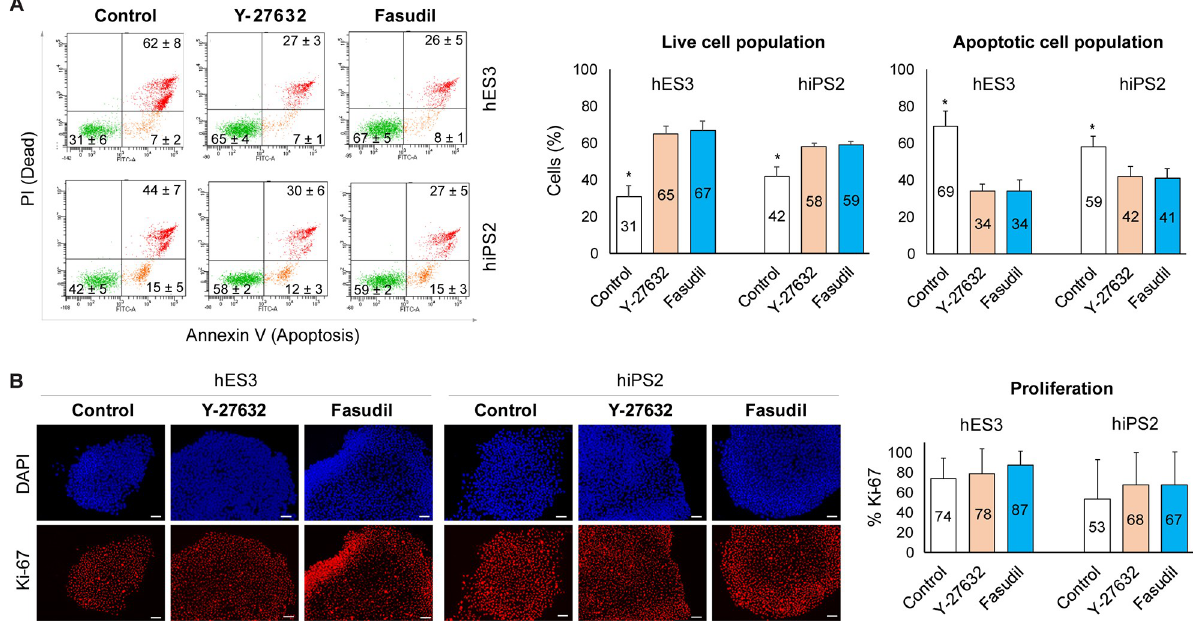
Fig 3. The mechanism of PSC growth. A: Analysis of live and apoptotic hES3 and hiPS2 cells (%) 24 hours after seeding at 1 × 10 4 cells/cm 2 . Compared with the control group, apoptotic cells decreased when treated with fasudil ( � : p < 0.05; 3 biological replicates). B: Cell proliferation measured using immunofluorescence (left) and flow cytometry (right) to examine Ki-67 expression in hES3 and hiPS2 cells 2 days after seeding. There were no significant differences between the groups (3 biological replicates). Scale bar = 100 μ m. hPSC: human pluripotent stem cell, hES: human embryonic stem cell, hiPS: human induced pluripotent stem